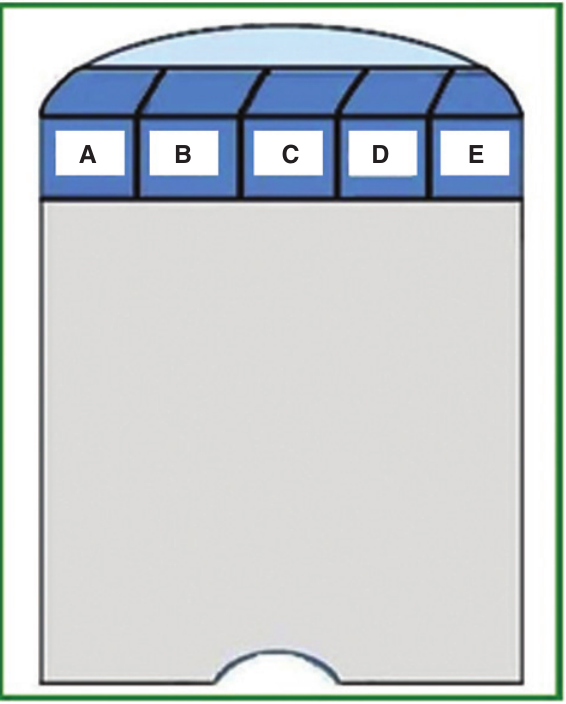
Figure 2 Cross-sectional view of the